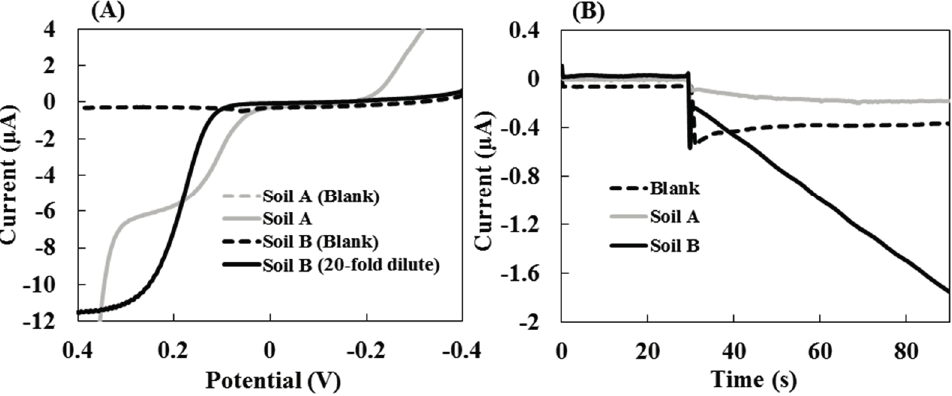
Figure 5. The AcP activity of real soil samples obtained from hydrodynamic ( A ) linear sweep voltammetry and ( B ) chronoamperometry. The linear sweep voltammogram of the soil B mixture was diluted 20-fold with MUB, at pH 6.0, after incubation for 60 min at 37 °C. The chronoamperogram measurements were performed using the RDE system at 0.3 V applied potential with a rotation rate of 3000